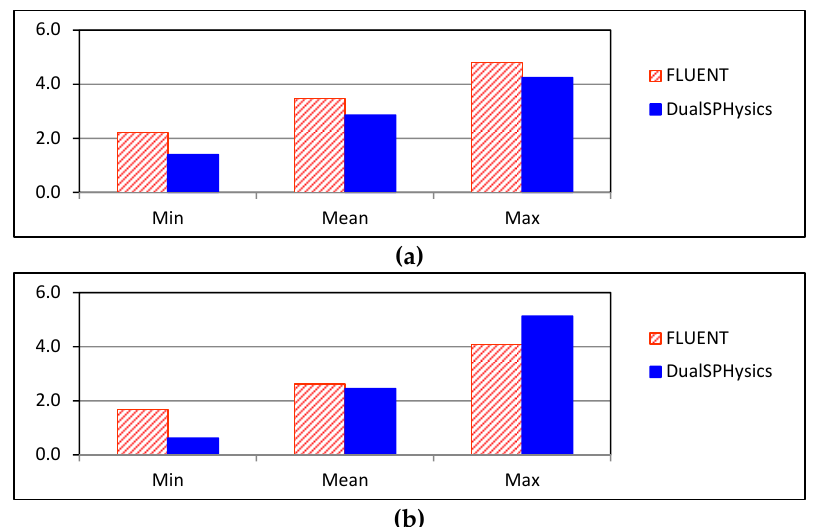
Figure 22. Minimum, mean, and maximum ( a ) wave overtopping discharge (m 3 /s/m) and ( b ) water flow height (m) at the crest of the groin head for FLUENT and DualSPHysics.